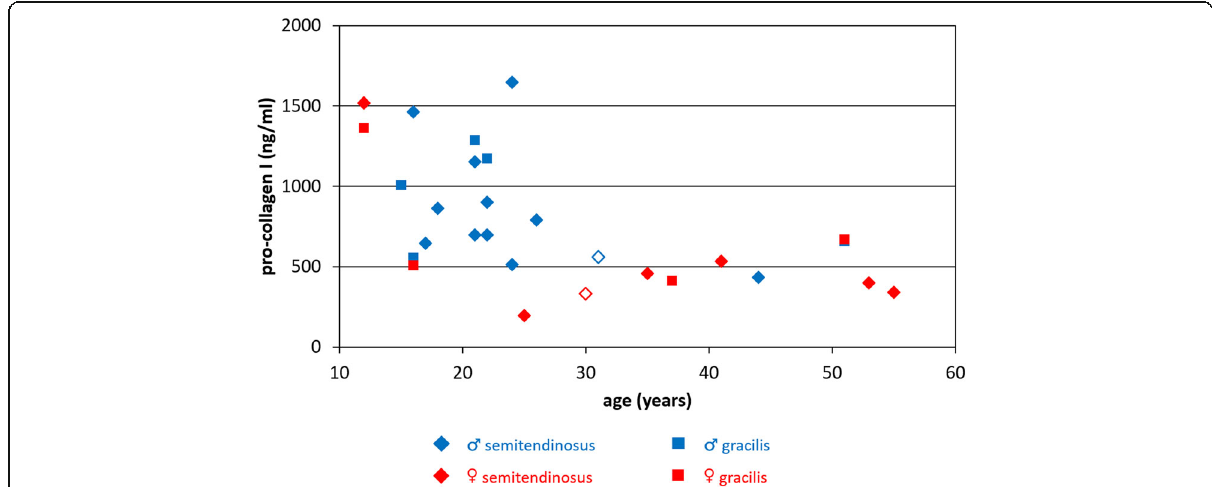
Fig. 4 Pro-collagen I content decreased with increasing patient age, with an apparent patient cut-off age around 25 years. Patient-specific human pro-collagen I α 1 content per micro-tissue was measured using ELISA and analyzed with respect to patient age. Outliers in cell lysate content are indicated by the open symbols . n =